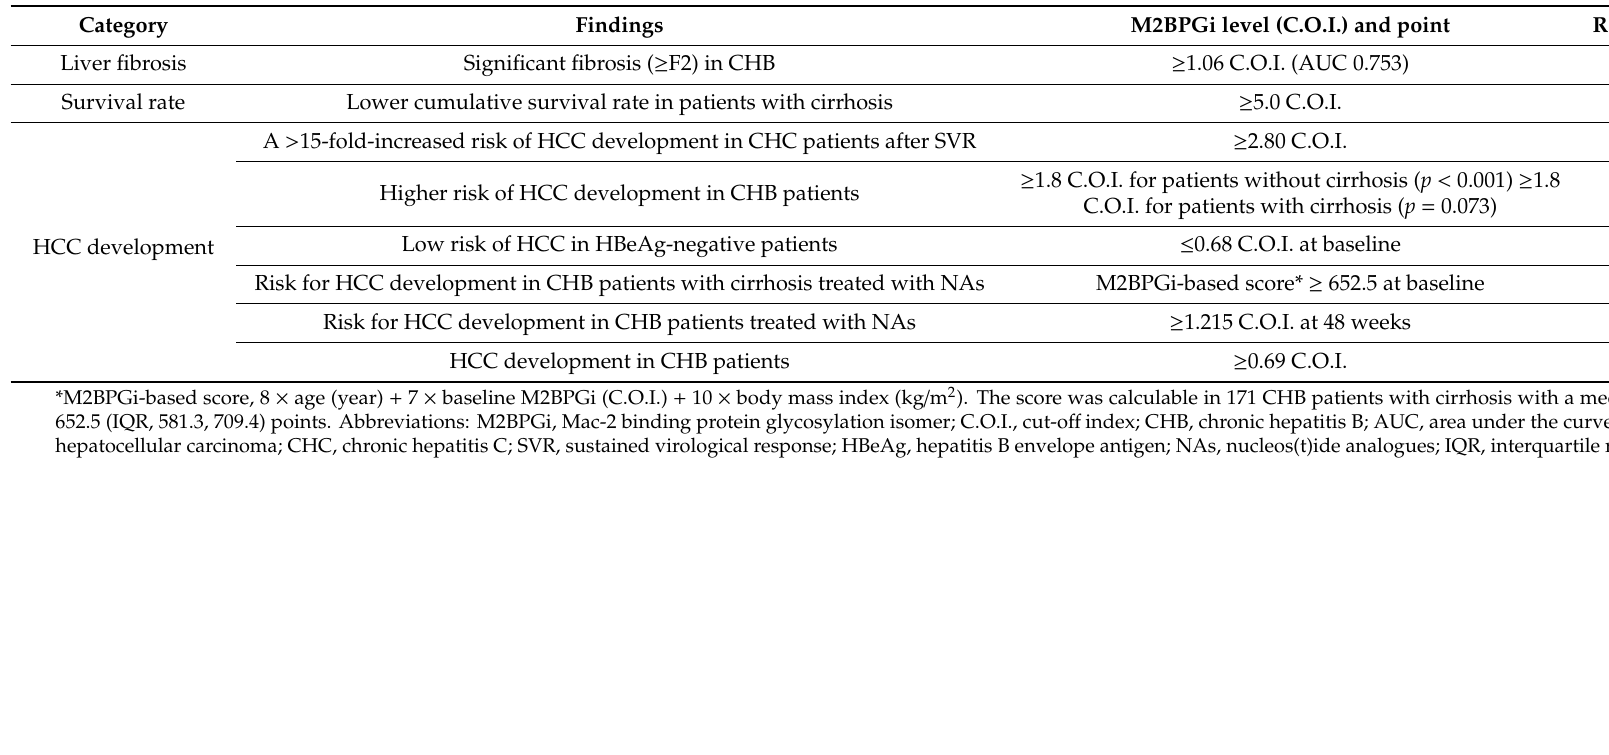
Table 2. Clinical applications of M2BPGi in patients with chronic liver